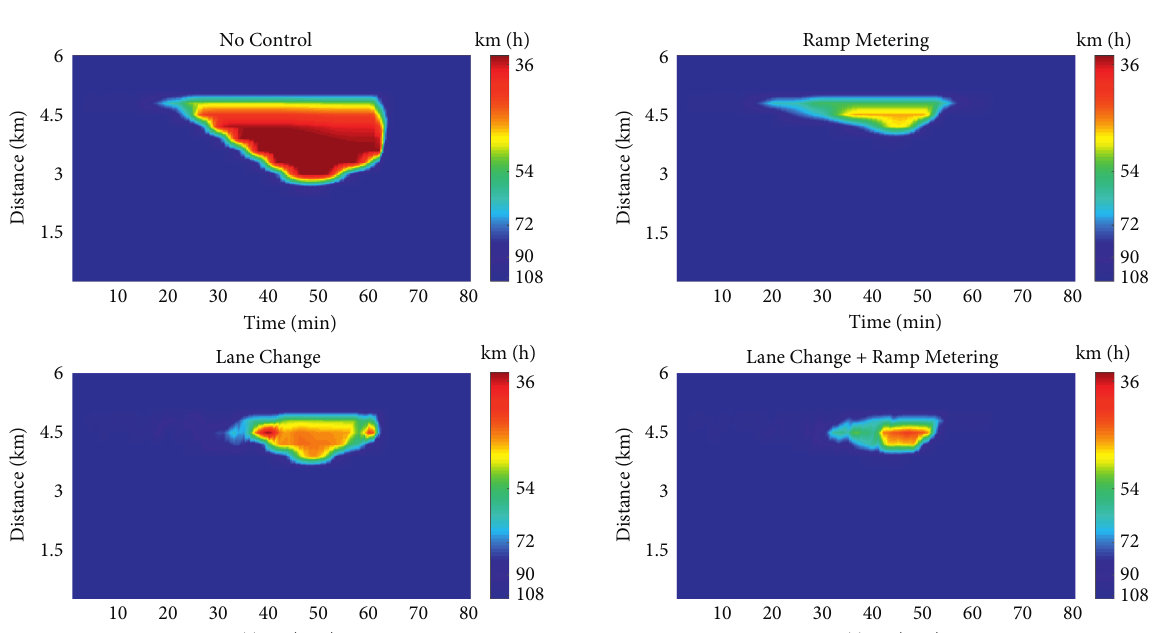
Figure 6: Pace (h/km) contour plots for the mainline. (a) No-control. (b) Ramp metering. (c) Lane change. (d) Lane change+Ramp metering